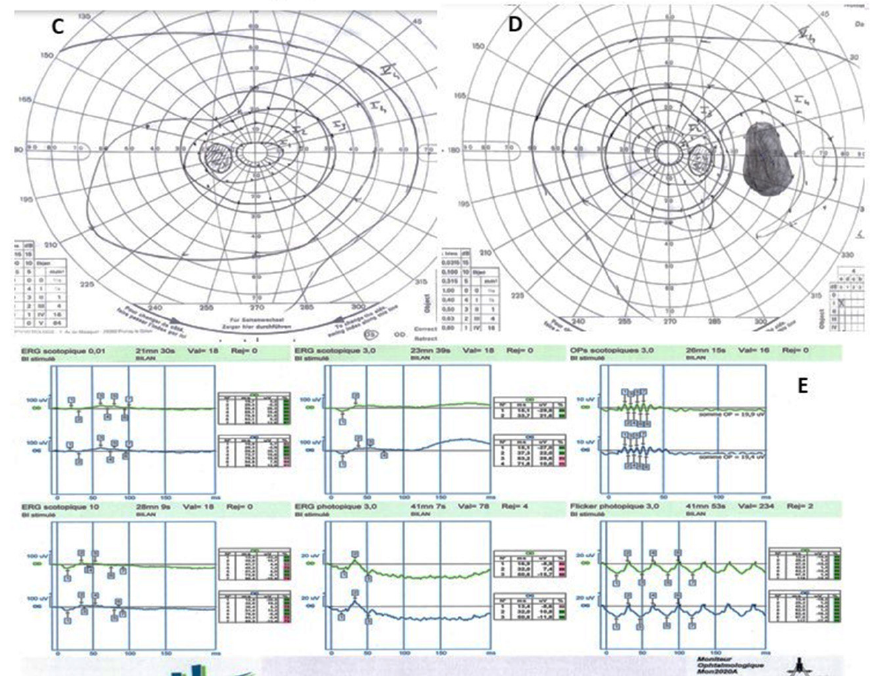
Figure 2. Farnsworth D-15 colour vision tests showed no abnormality in either eye ( A , B ). Goldmann kinetic visual field revealed ( C ) a superior temporal depression with the I4e isopter in the left eye and ( D ) absolute scotomas in the temporal mid-peripheral field between 30 ° and 60 ° in the right eye. A full-field electroretinogram (ERG) revealed moderate generalized rod and cone dysfunction in both eyes ( E ).